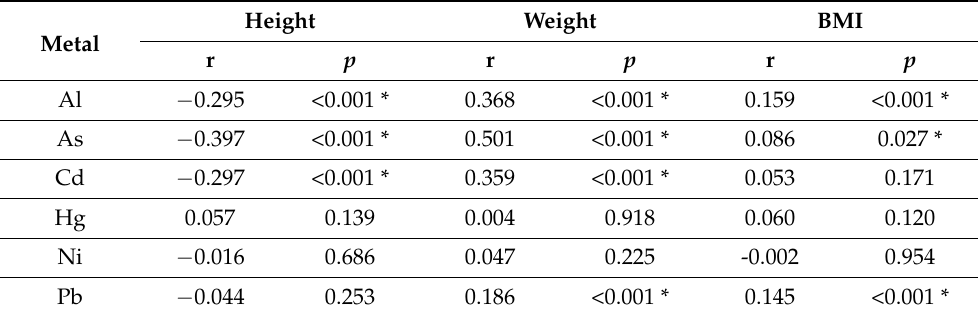
Table 4. Correlation analysis of the association between hair toxic metal levels and anthropometric parameters in the studied